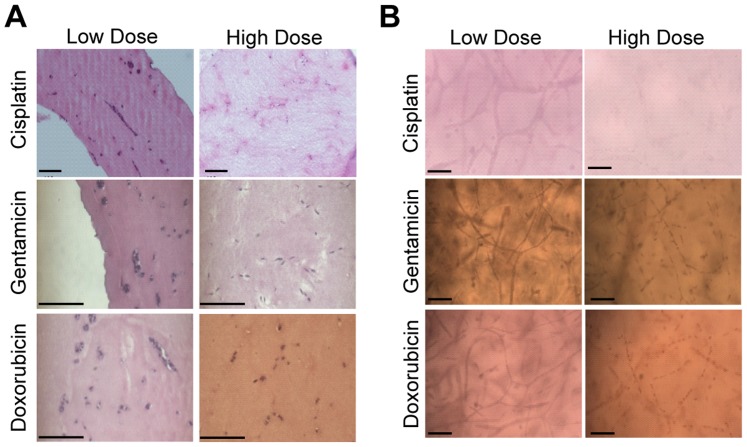
Morphology of 3D tissues after treatment with cisplatin, gentamicin, and doxorubicin.Tissues were fixed after 2 weeks of drug treatment. (A) 8 µm sections were stained with hematoxylin and eosin to visualize changes in tissue structure. (B) Whole fixed tissues were stained with carmine for whole mount visualization of tissue structure. Low dose refers to the lowest does tested and high dose refers to the highest dose tested. Scale bars  =  50 µm.